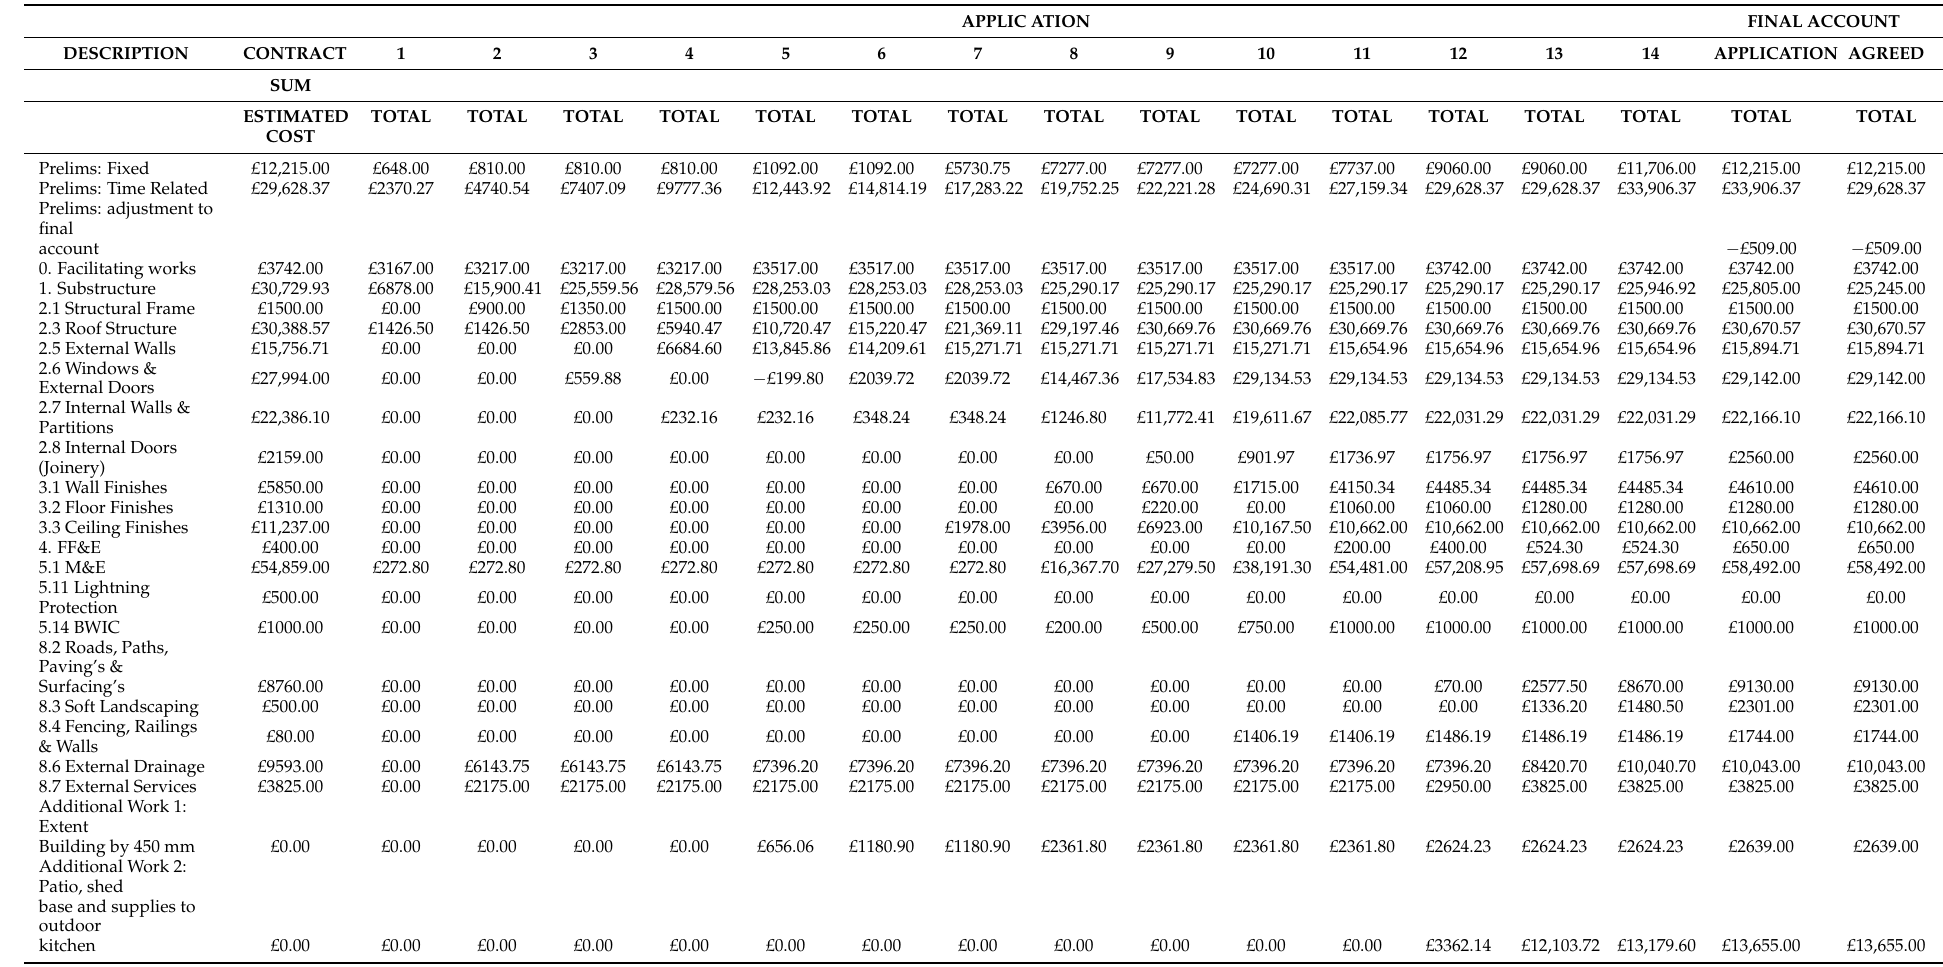
Table 3. Cost data to show bimonthly cumulative